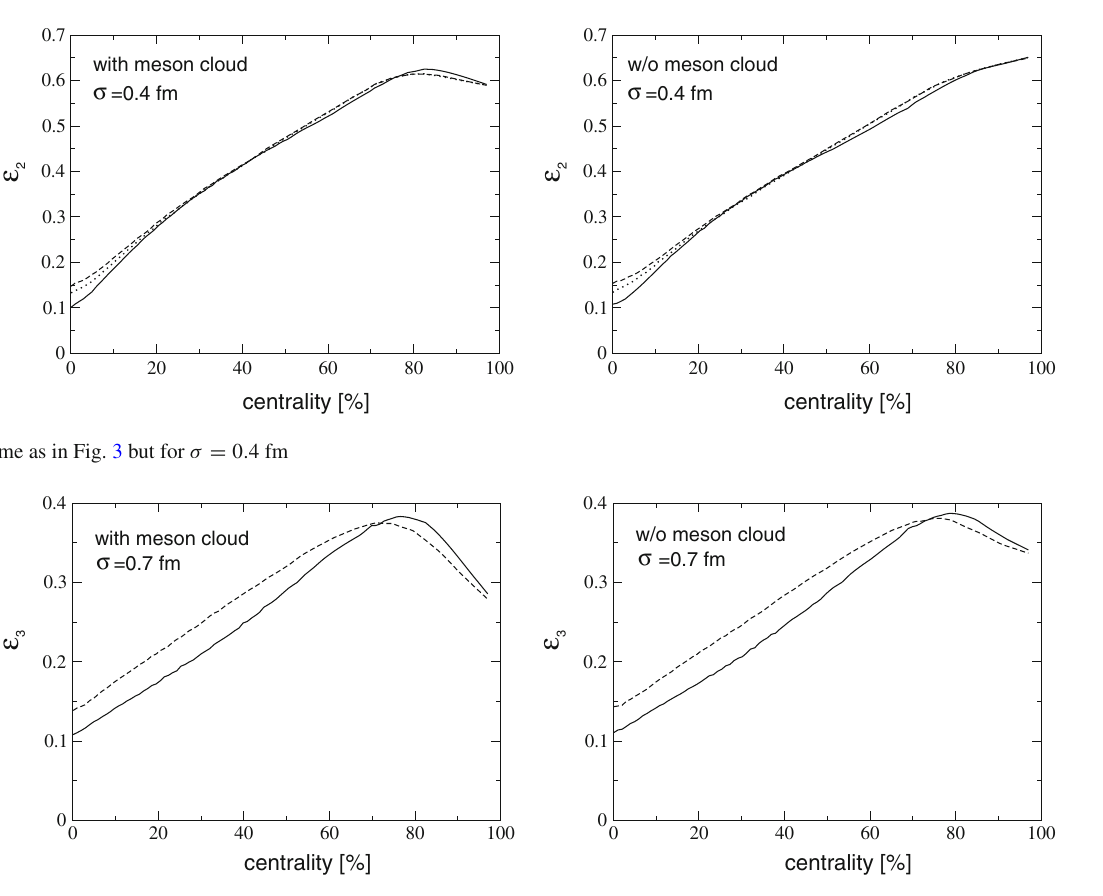
Fig. 5 Centralitydependenceoftherms ε 3 fortheGaussiansourcedis- Woods–Saxondistribution(dashed).Left:theversionwithmesoncloud √ s = 5 . 02 TeV tribution (8) for σ = 0 . 7 fm for Pb + Pb collisions at at α = 0 . 09. Right: the version without meson cloud at α = 0 . 13 √ s = 5 . 44 TeV for the θ -dependent (solid) and Xe + Xe collisions at